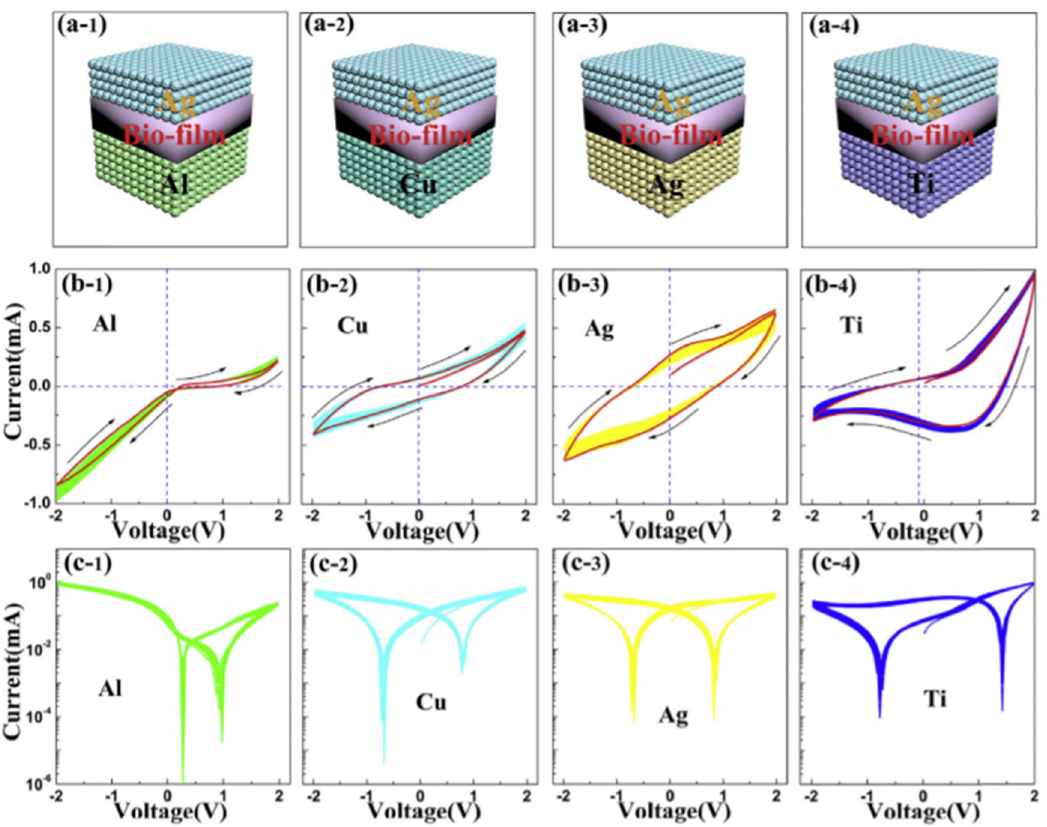
Figure 17: Four di ff erent types of bottom electrodes ( Al, Cu, Ag, and Ti ) with fi xed topelectrode of Ag for the mushroom - based RRAM with the schematic device structures shown in ( a - 1 to a - 4 ) and current – voltage ( I – V ) characteristic curves presented in linear ( b - 1 to b - 4 ) and semi - log ( c - 1 to c - 4 ) plots [ 19 ]